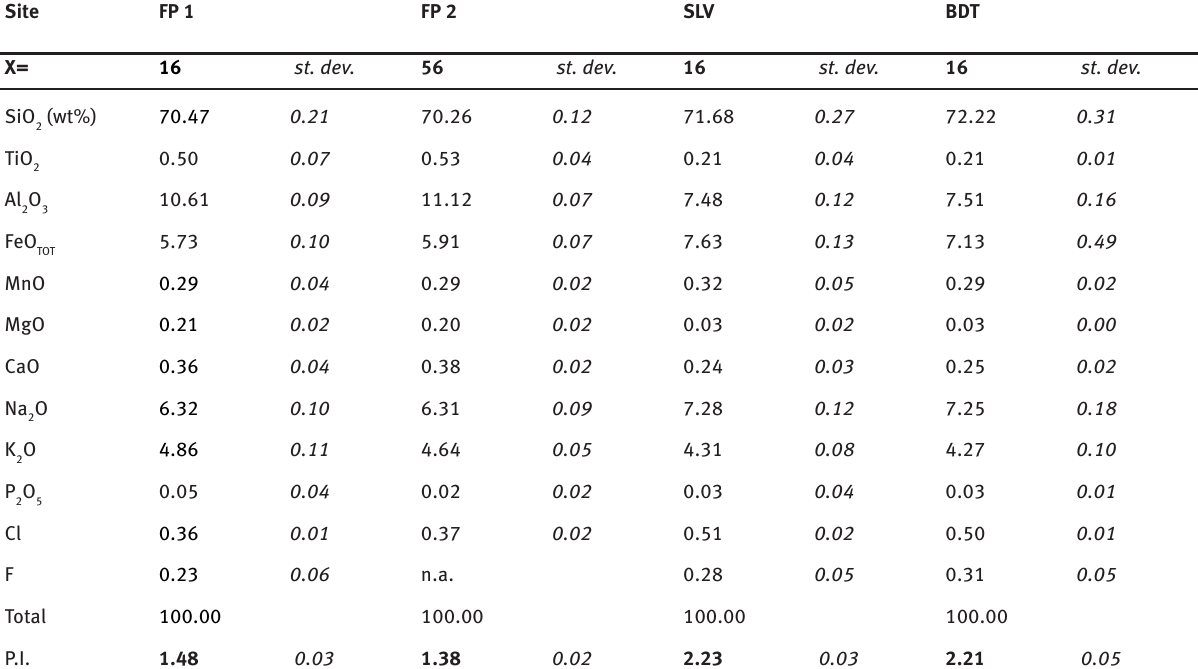
O+K O)/Al O . Site abbreviations as in Table 1. 2 2 2 3